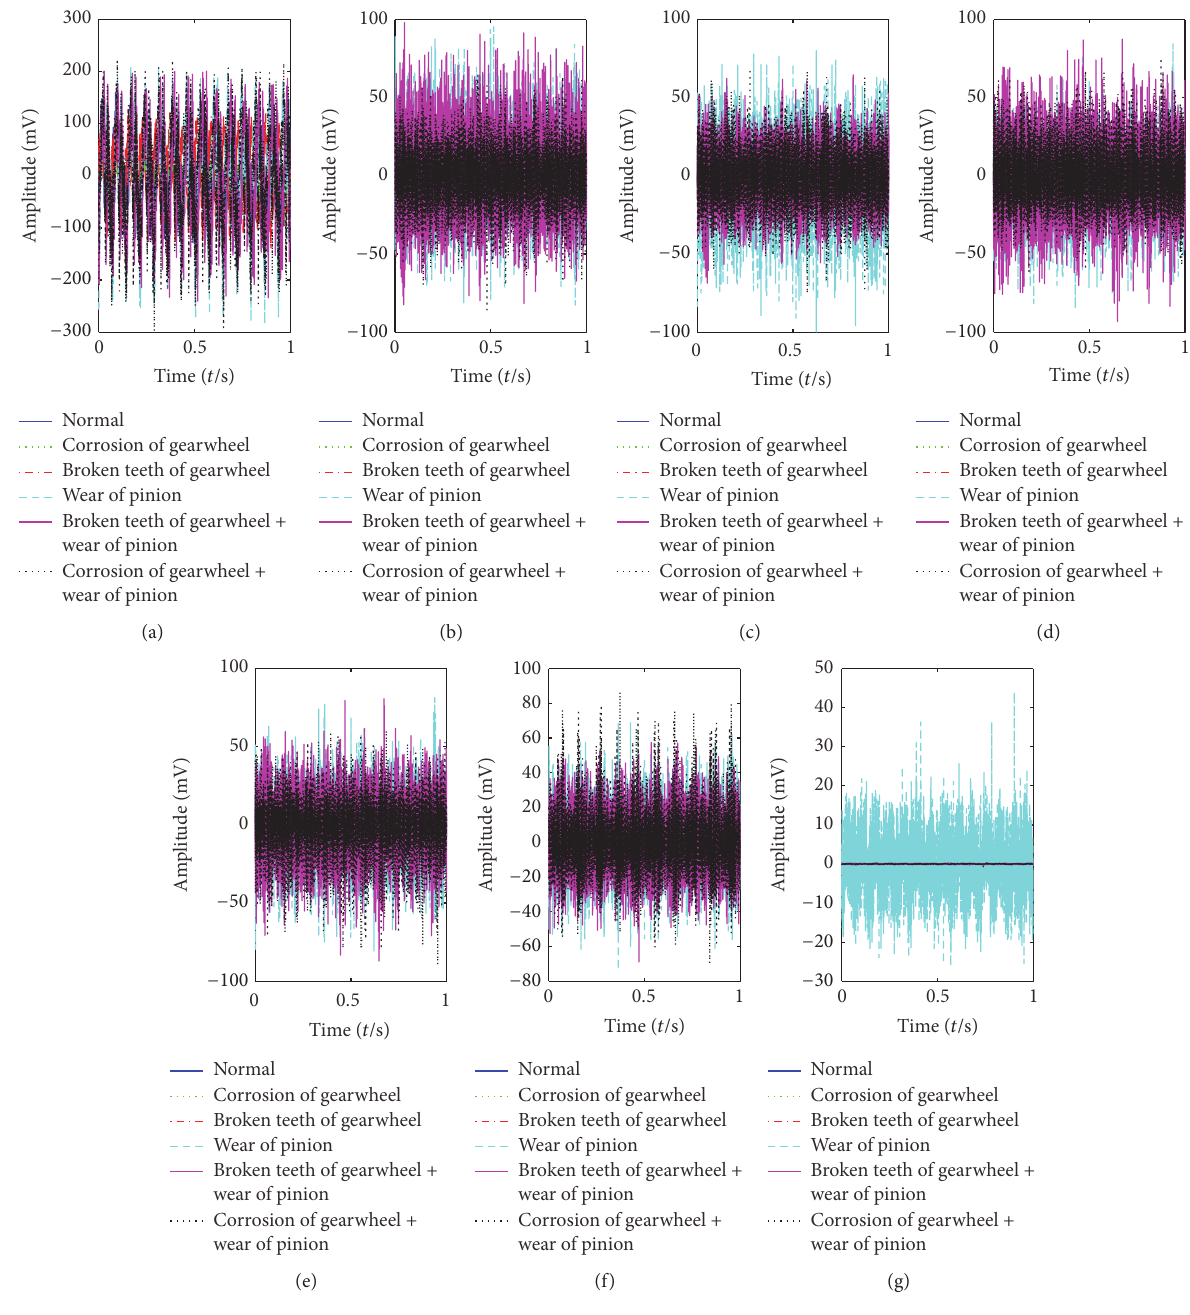
Figure 4: Test signals originating from each single sensor under six conditions: (a) 1# sensor, (b) 2# sensor, (c) 3# sensor, (d) 4# sensor, (e) 5# sensor, (f) 6# sensor, and (g) 7#